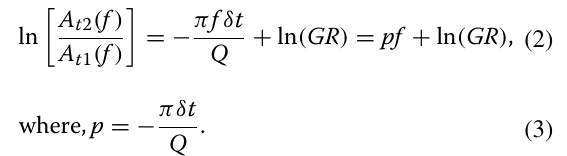
Fig. 2. Continuous reflections, as well as the faults that cut them, are clearly visible in the profile. Based on noise level analysis using the amplitude decay curve (Fig. 3),